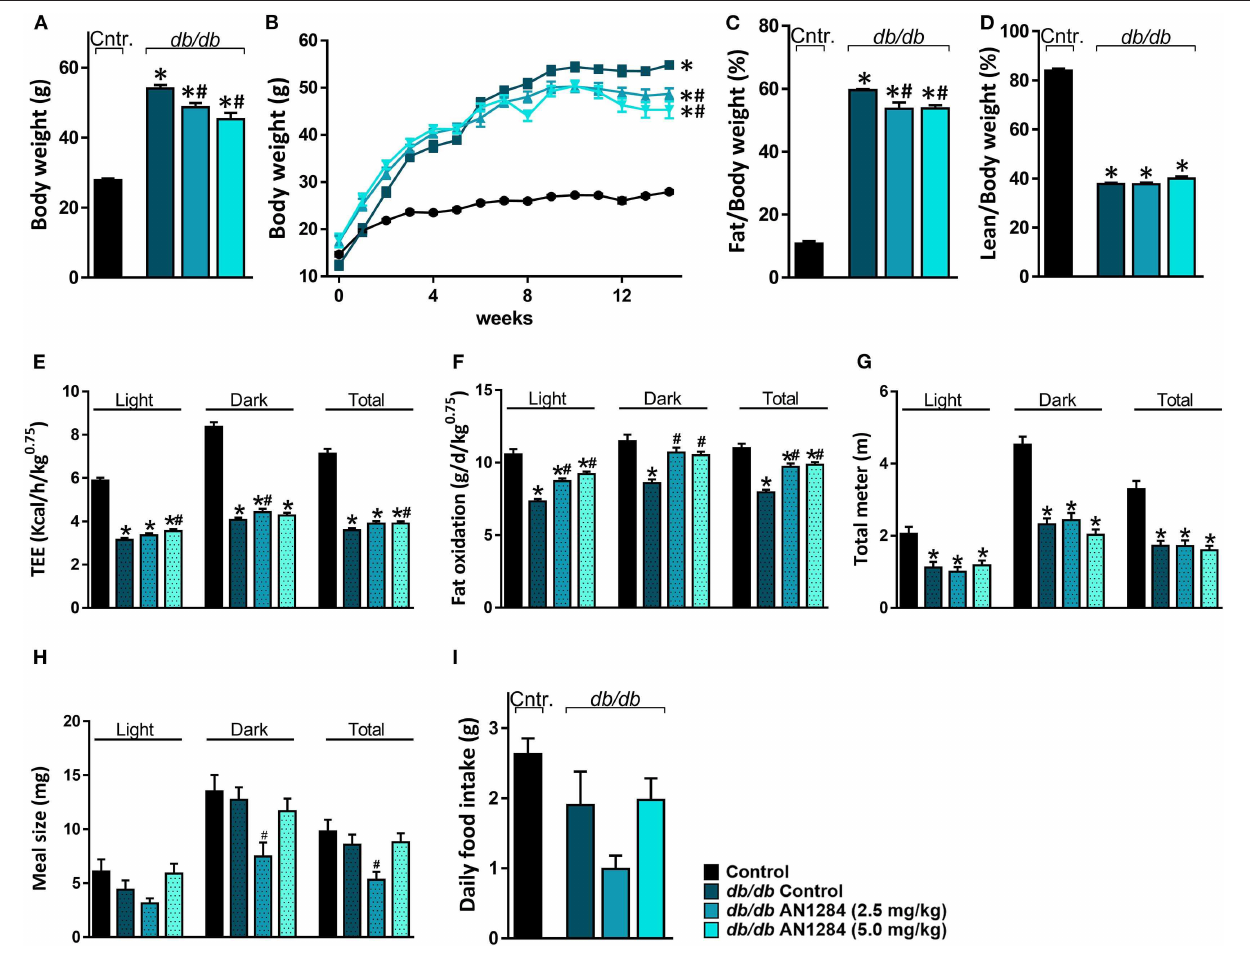
FIGURE 4 | AN1284 mitigates increased body weight in db/db mice via increasing fat oxidation. Chronic treatment with AN1284 significantly attenuated the increased body weight (A,B) and fat mass (C) without affecting lean mass (D) in db/db mice. Significant increases in total energy expenditure (TEE; E ) and fat oxidation (F) were measured in db/db mice chronically treated with AN1284. No effect was found on mouse activity as measured by the total distance the mice moved in their cages (G) . db/db mice treated with the lower dose of AN1284 exhibited decreased meal size (H) , without a significant effect on daily food intake (I) . Data represent the mean ± SEM from 8 to 10 mice per group. * P < 0.05 relative to control non-diabetic mice, # P < 0.05 relative to db/db -Veh-treated control